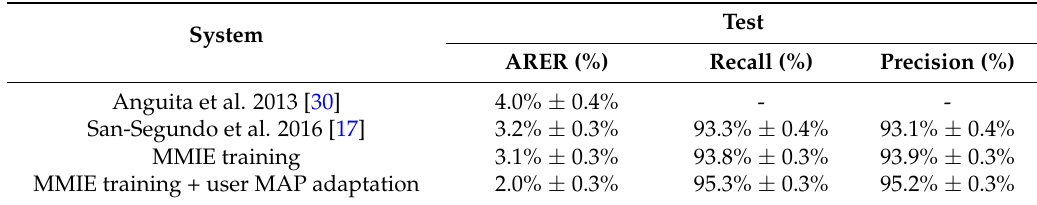
Table 3. Final results considering the original dataset partition including activity recognition error rate (ARER), recall and precision